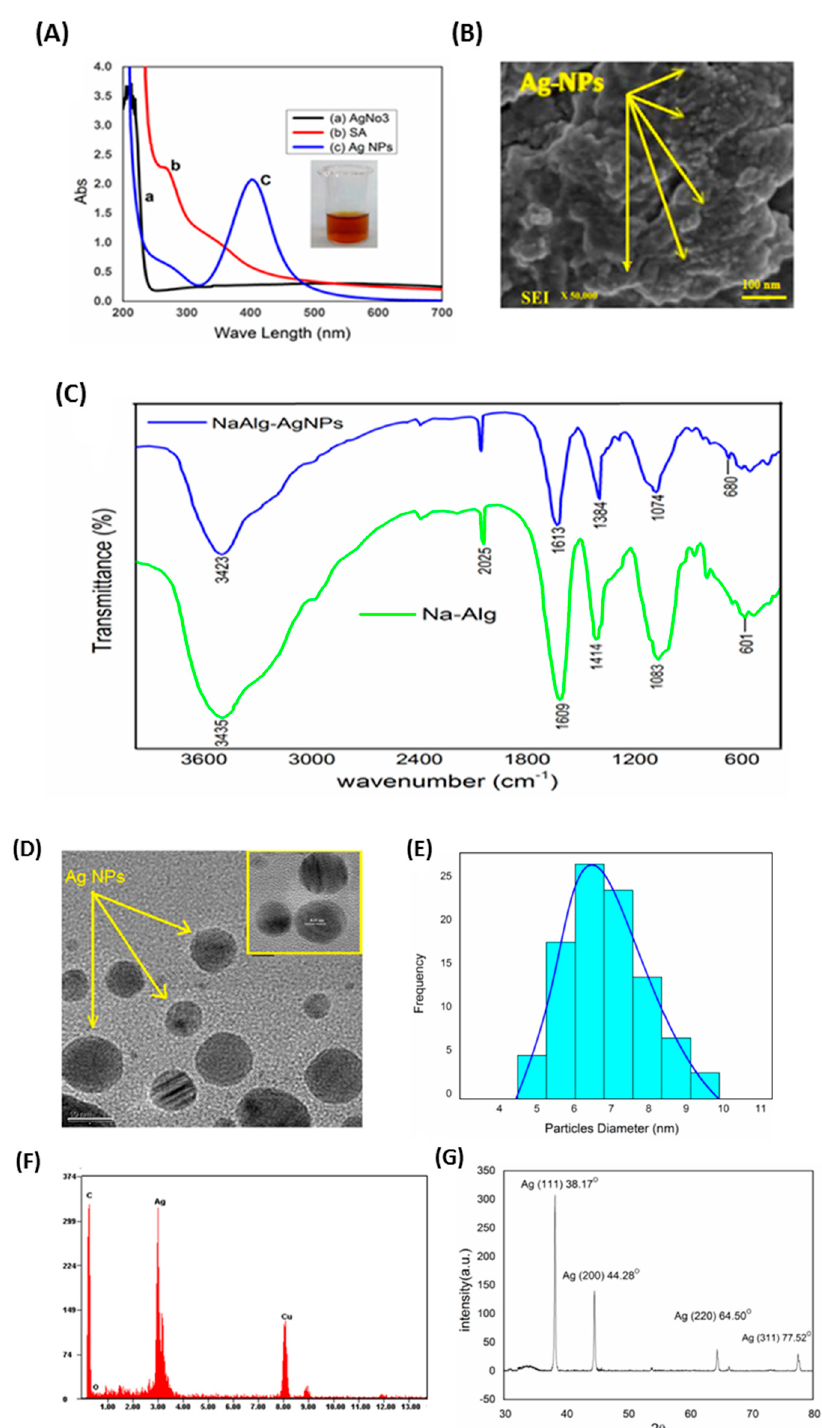
Figure 1. ( A ) UV–vis spectra; ( B ) SEM; ( C ) Fourier transform infrared (FT-IR) spectra; ( D ) TEM; ( E ) size distribution (PSD); ( F ) energy dispersive X-ray spectroscopy (EDS); and ( G ) XRD of particle size distribution ( PSD); ( F ) energy dispersive X-ray spectroscopy (EDS); and ( G ) XRD of AgNPs.